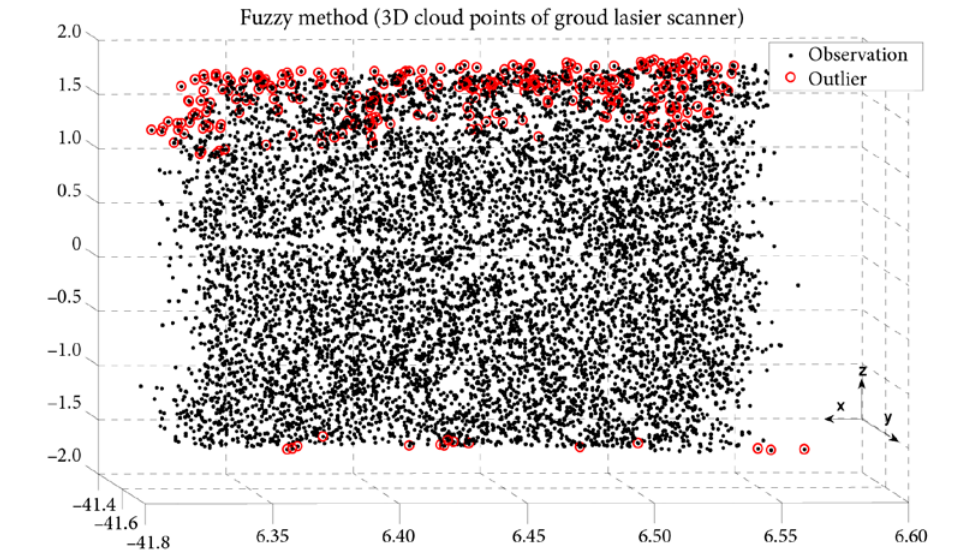
Fig. 3. Outliers detection based on Fuzzy approach applied into the 3D point clouds of the ground-based laser scanner ( x, y and z [m] are assumed in a local coordinate